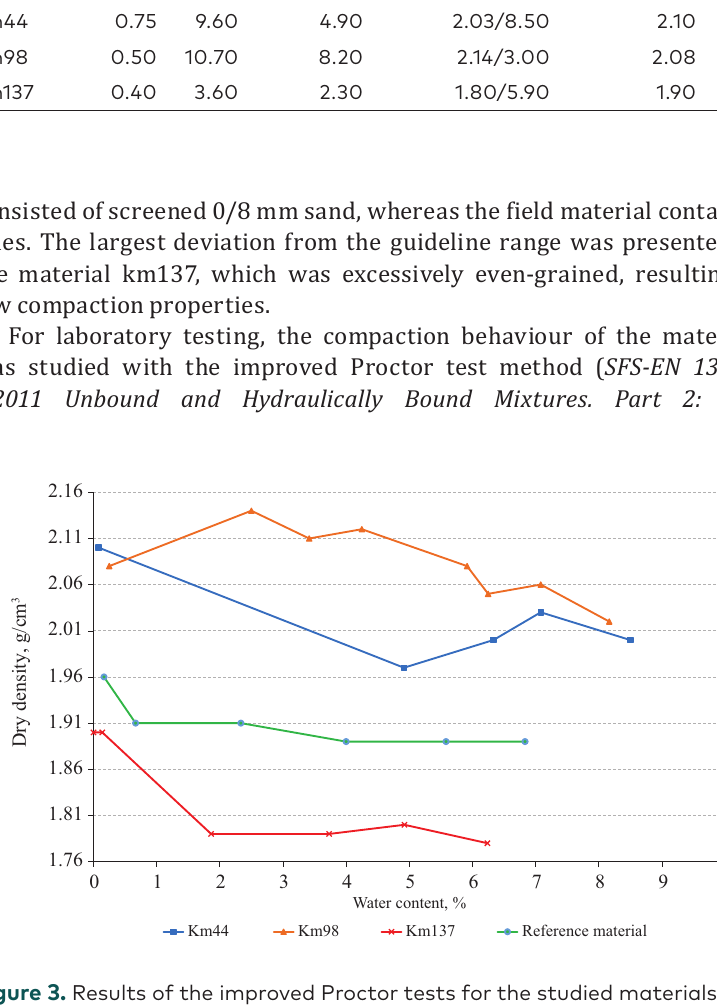
Figure 3. Results of the improved Proctor tests for the studied